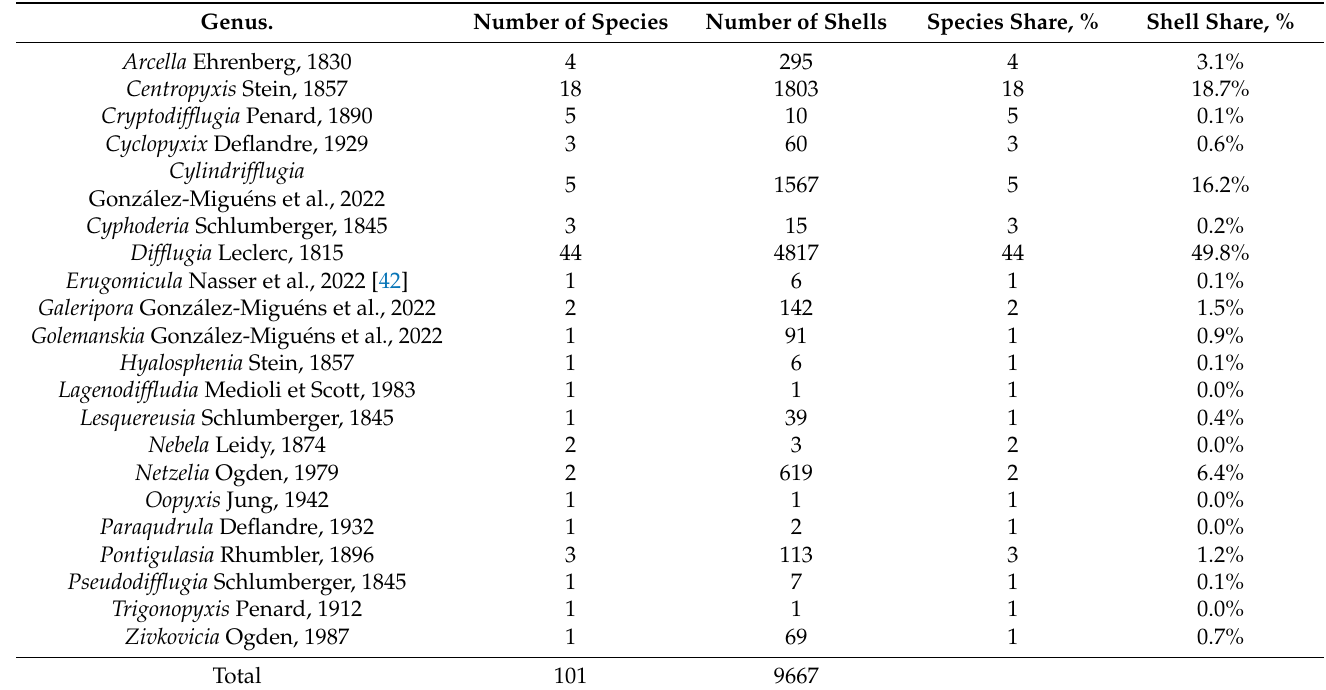
Table 1. The list of testate amoeba genera with the number of species and counts along the transect. Genus.